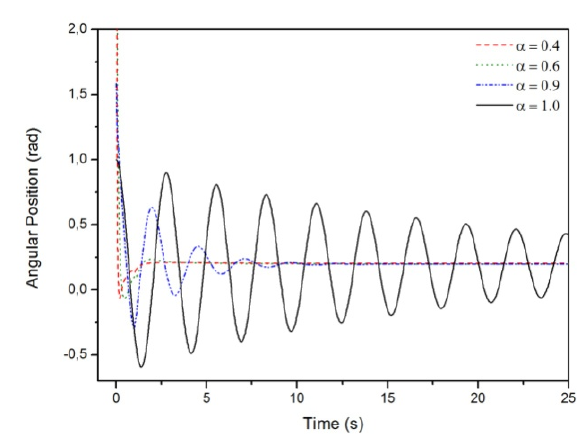
Figure 12. Time history (values of α ≤ 1).